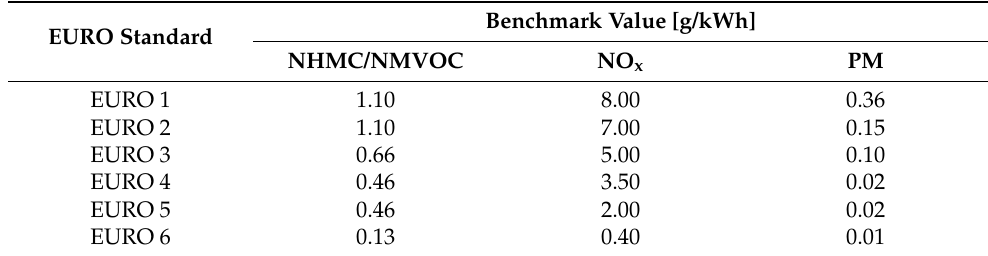
Table 1. Emission factors for pollutant generated by diesel buses depending on the EURO